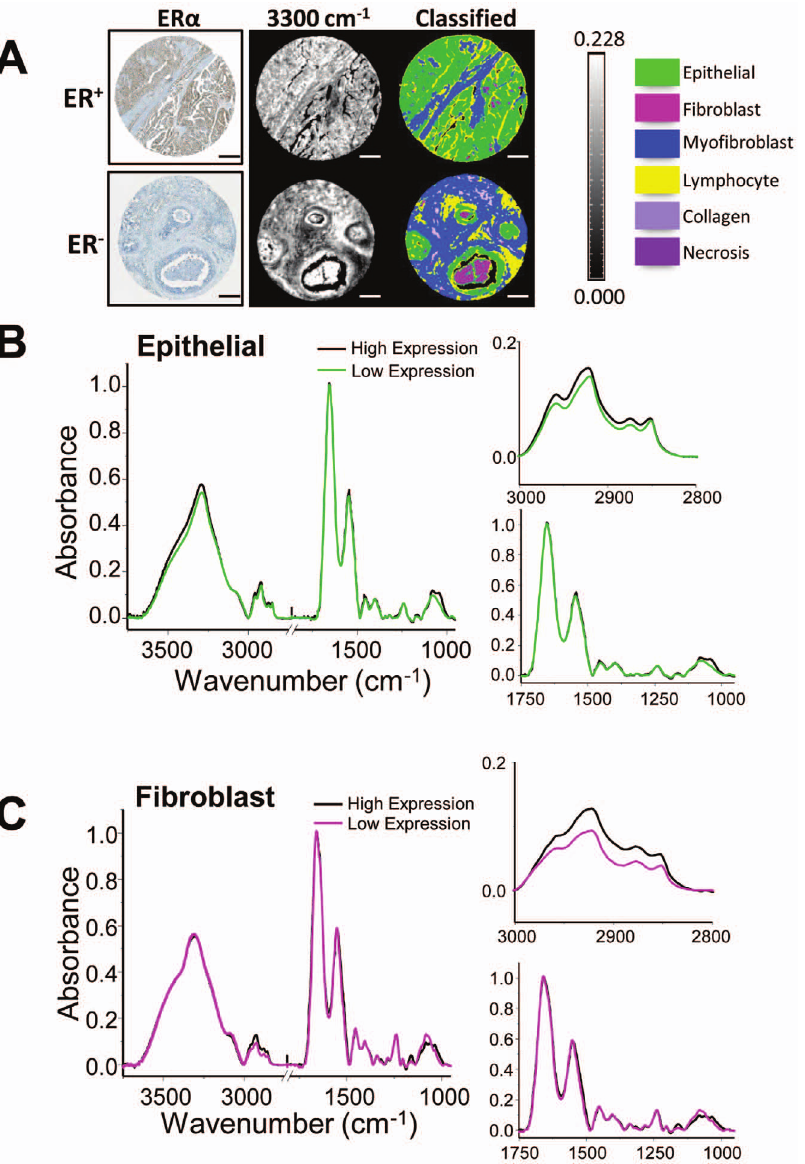
Figure 7. Spectroscopic signatures determined using 3D co-culture models can be translated to human breast tissue samples. (A) Tissue microarray (TMA) biopsy cores (1.5 mm core diameter) were IHC stained for ER a and also imaged using FT-IR imaging (N-H/O-H band at 3300 cm 2 1 visualized here for clarity). Images classified using Bayesian classifier are displayed as well to highlight the ability of FT-IR to discriminate between cell types in complex samples. Scale bar represents 250 m m. (B) Differences between epithelial pixels in patient samples with high ( . 80%) and low ( , 20%) expression of ER a can be seen in peaks at 1080 cm 2 1 (phosphate) and 1030 cm 2 1 (glycosidic bonds). Interestingly, there are more apparent differences in these peaks when pixels from fibroblasts are analyzed. Full spectrum (3800 – 950 cm 2 1 ), C-H stretching region (3000 – 2750 cm 2 1 ), and biochemical fingerprint region (1750 – 950 cm 2 1 ) are shown. normalized to MCF-7 vehicle control, while 3:1 treatments were normalized to the 3:1 vehicle control) in Excel and plotted in GraphPad. All samples were prepared in duplicate.